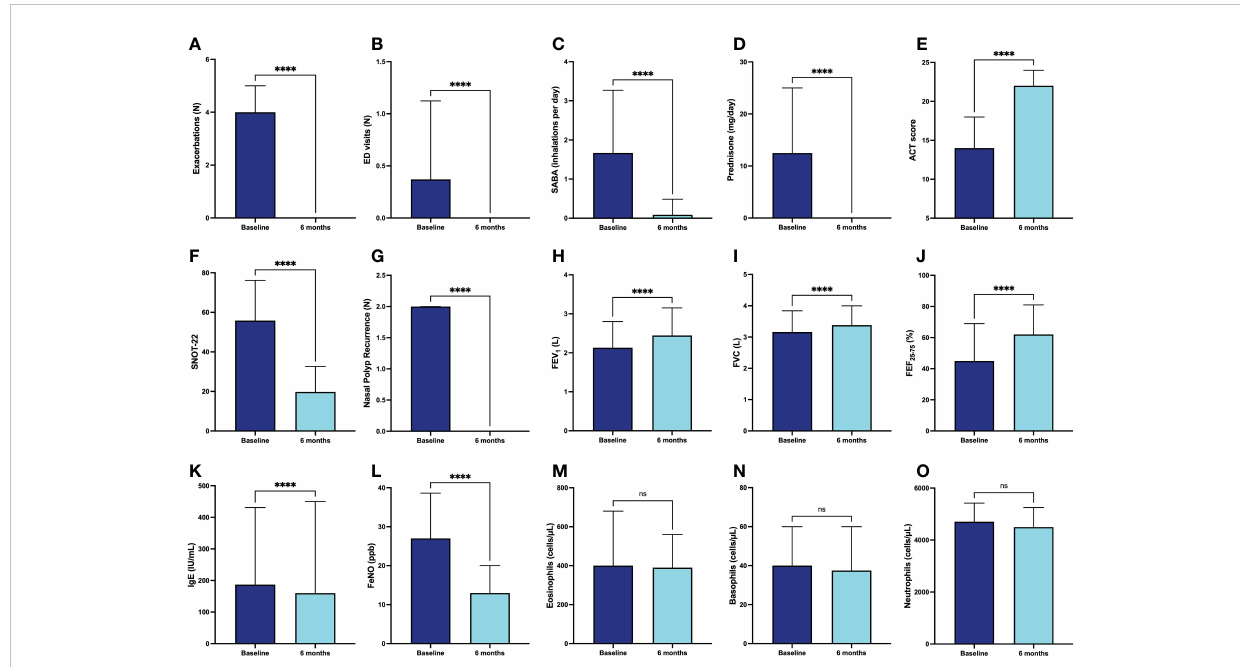
FIGURE 1 Ef fi cacy of dupilumab in the whole population of patients with severe asthma, with regard to asthma exacerbations (A) , ED visits (B) , daily SABA inhalations (C) , prednisone intake (D) , ACT score (E) , SNOT-22 (F) , nasal polyp recurrence (G) , FEV1 (H) , FVC (I) , FEF25-75 (J) , IgE (K) , FeNO (L) , blood eosinophils (M) , blood basophils (N) , and blood neutrophils (O) . Values of ED visits, daily SABA inhalations and SNOT-22 are expressed as mean (± SD). All other parameters are expressed as median values (IQR). **** p < 0.0001; ns, not signi fi